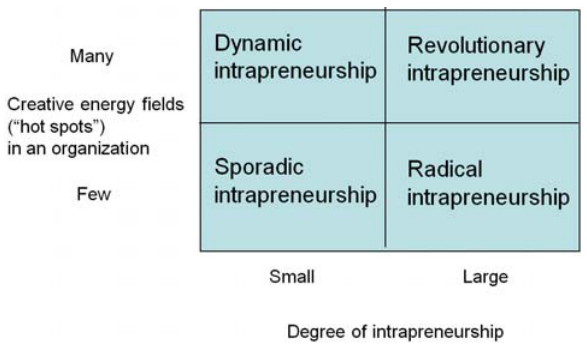
Fig. 5. Strategic entrepreneurship and intrapreneurial